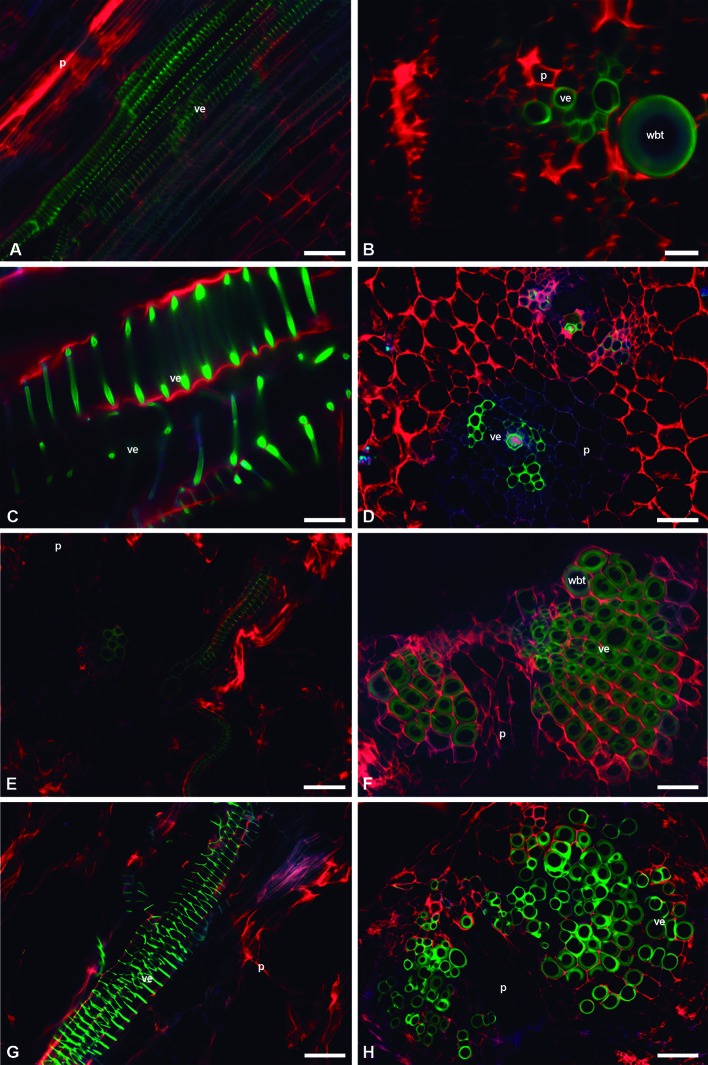
Image seedling stems of fibrous, non-fibrous, and dimorphic species with triple-band excitation fluorescence. (A, C, E, G) Longitudinal sections. (B, D, F, H) Transverse sections. (A, B)
Opuntia streptacantha. (C, D)
Echinocactus platyacanthus. (E, F)
Ferocactus pilosus. (G, H)
Mammillaria carnea. Bar is 50 µm in (A, D–H); 100 µm in (B); and 20 µm in (C). p, parenchyma; ve, vessel element; wbt, wide-band tracheid.